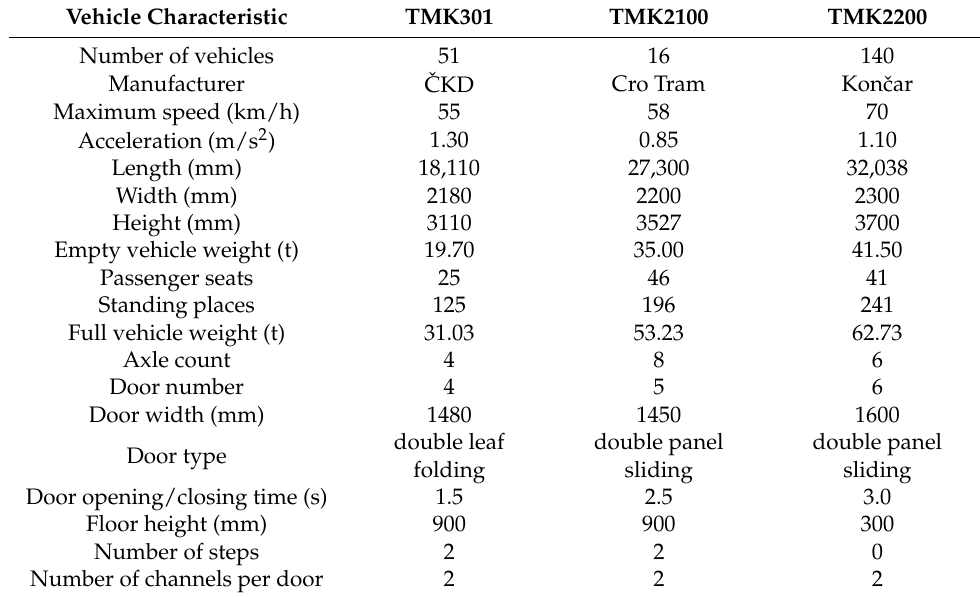
Table 5. Tram vehicles characteristics.